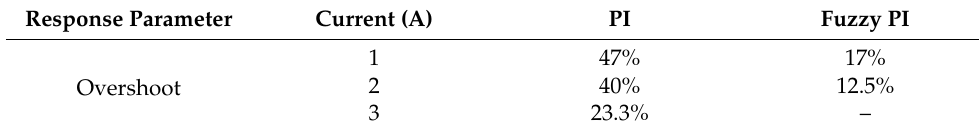
changes. Table 7. Overshoot of PI and fuzzy PI controllers at different step currents after parameter changes.